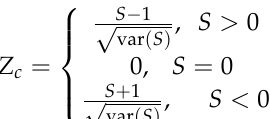
Figure 3. Spatial distribution of seasonal PW trends over China during 1979–2020 (unit: kg·m − 2 ·yr − 1 ). The stippled areas indicate that the trends passed the significance test at the 95% confidence level. ( a ) Spring, ( b ) Summer, ( c ) Autumn, ( d ) Winter. The above analysis of the distribution and long-term trend of the climatic state of PW in China in all seasons reveals that water vapor content is more abundant in all regions in summer compared with other seasons, and the regions where water vapor content changes at a faster rate and passes the significance test are also significantly larger. Evi- dently, it is of great practical importance to study the variation in AWR in summer; there- fore, the following research on cloud parameters and CWR characteristic quantities fo- cused on the summer period only. 3.2. Long-Term Trends of Cloud Cover and CWC in Summer Zhang et al. [59] conducted a comparative analysis using multiple reanalysis data and ISCCP data with actual observations in China and found that the total cloud cover measurements of ERA5 had the highest agreement with ground observations, with a cor- relation coefficient of 0.91. Therefore, in this study, we used ERA5 data to study the cloud cover characteristics of China’s regions. Figure 4 shows the distribution of monthly mean